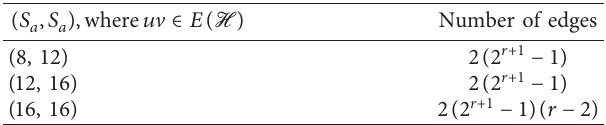
Table 3: Partition of edge set of HCB ( r ) ,r ≥ 4, built on degree sum of neighbor vertices of end vertices of each edge.